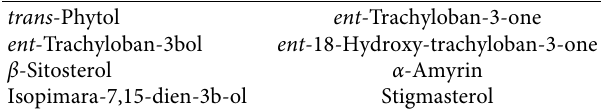
Table 4: Diterpenoids